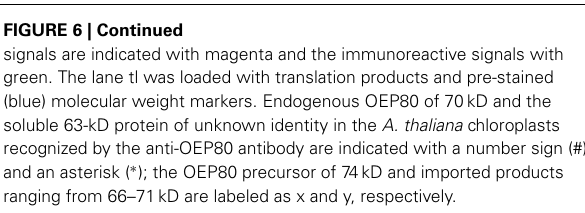
FIGURE 6 | Continued signals are indicated with magenta and the immunoreactive signals with green. The lane tl was loaded with translation products and pre-stained (blue) molecular weight markers. Endogenous OEP80 of 70kD and the soluble 63-kD protein of unknown identity in the A. thaliana chloroplasts recognized by the anti-OEP80 antibody are indicated with a number sign (#) and an asterisk ( ∗ ); the OEP80 precursor of 74kD and imported products ranging from 66–71kD are labeled as x and y,